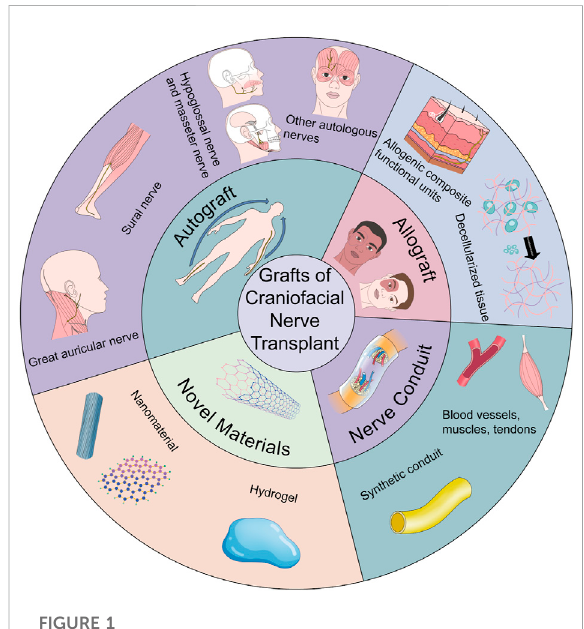
FIGURE 1 The brief description on donors for nerve transplantation in craniofacial soft tissue